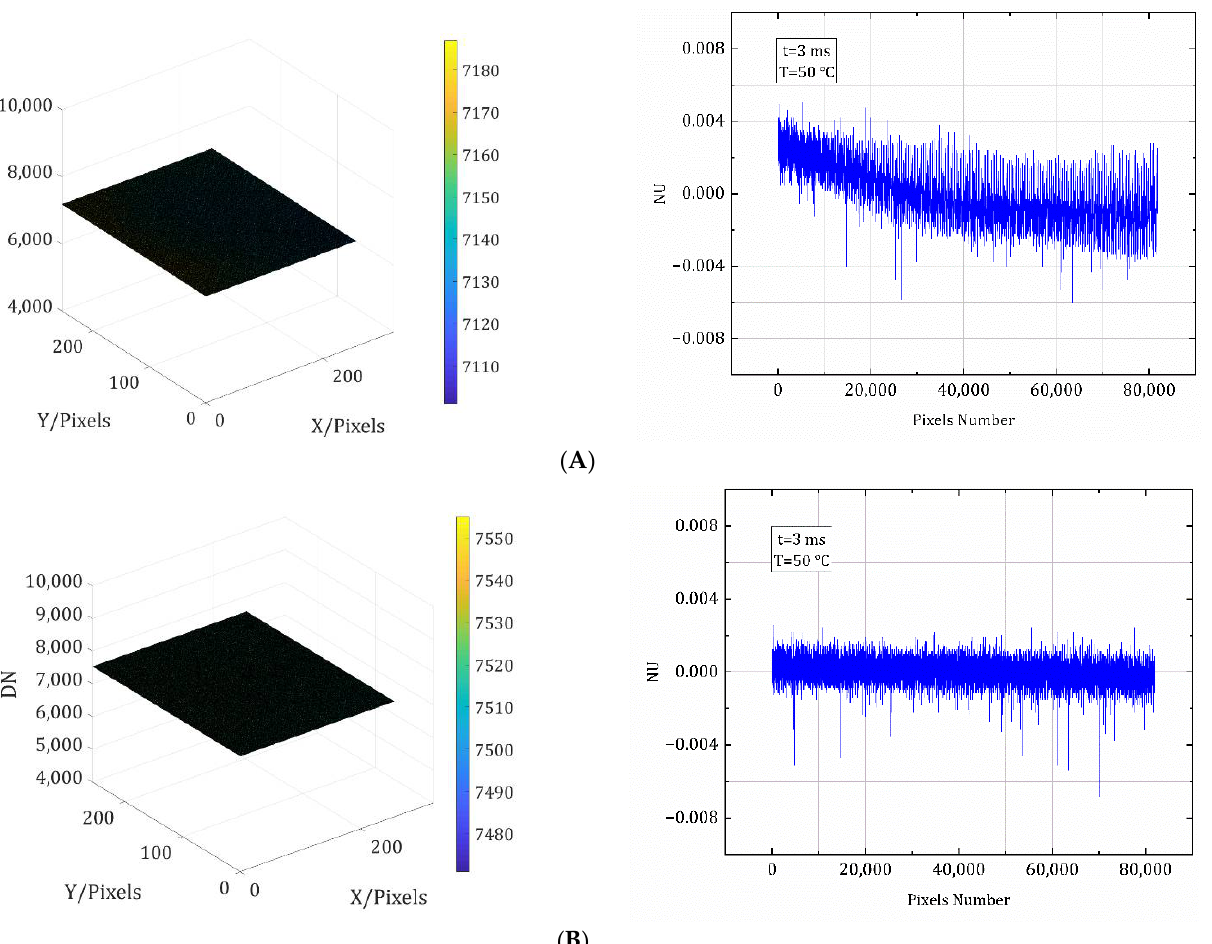
Figure 5. ( A ) Grayscale distribution of the detector’s target surface at 3 ms and 50 °C , and non-uniformity of each pixel of the correction image, with lens . ( B ) Grayscale distribution of the detector’s target surface at 3 ms and 50 °C , and non-uniformity of each pixel of the correction image, without lens .